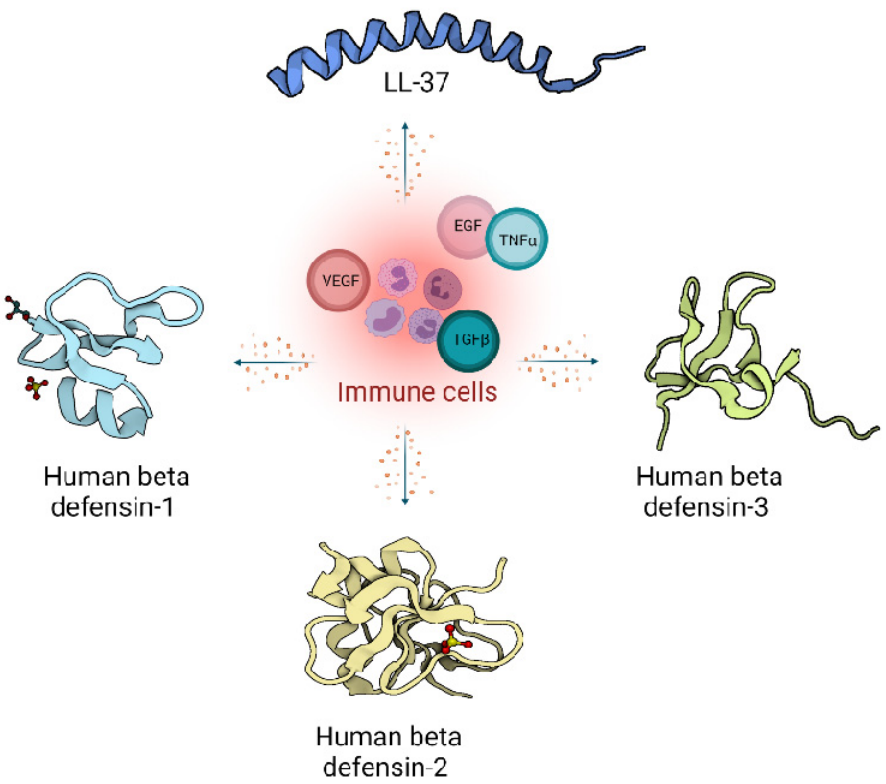
Figure 1. Host defence peptides expressed by skin cells are induced by immune response, and act via signalling proteins belonging to growth factors like Vascular Endothelial Growth Factor (VEGF), Transforming Growth Factor beta (TGF β ), Epidermal Growth Factor (EGF) and cytokines like Tumor Necrosis factor alpha (TNF α ). Immune cells produce LL-37 from the cathelicidin family (Pdb code: 2K6O) [10] and defensin family: Human defensin 1 (Pdb code: 1IJU) [38], Human defensin 2 (Pdb code: 1FD4) [39], Human defensin 3 (Pdb code: 1KJ6) [40].